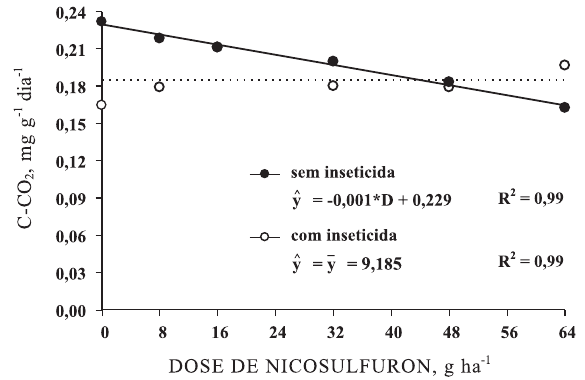
Figura 4. Quociente metabólico de amostras de solo determinado 75 dias após a aplicação de doses do herbicida nicosulfuron em diferentes doses, isolado ou simultaneamente ao inseticida chlorpyrifos (240 g ha -1 ). D = doses; ** e *: signifi- cativo pelo teste t a 10 e 5 %,